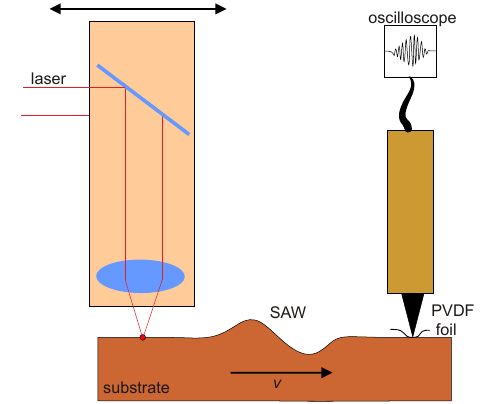
Figure 2. Schematic representation of the LAW